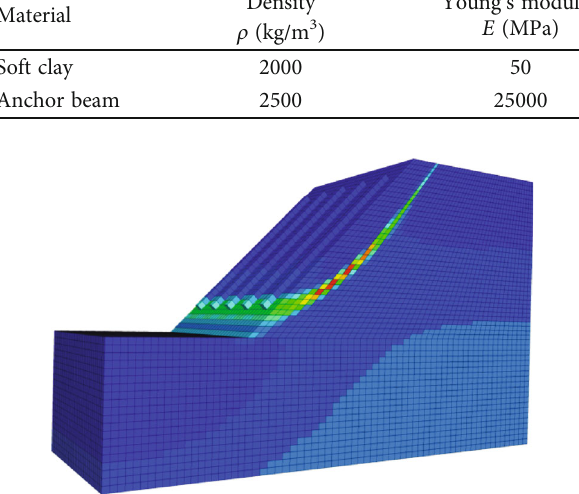
Figure 12: Initial equilibrium state of the slope.